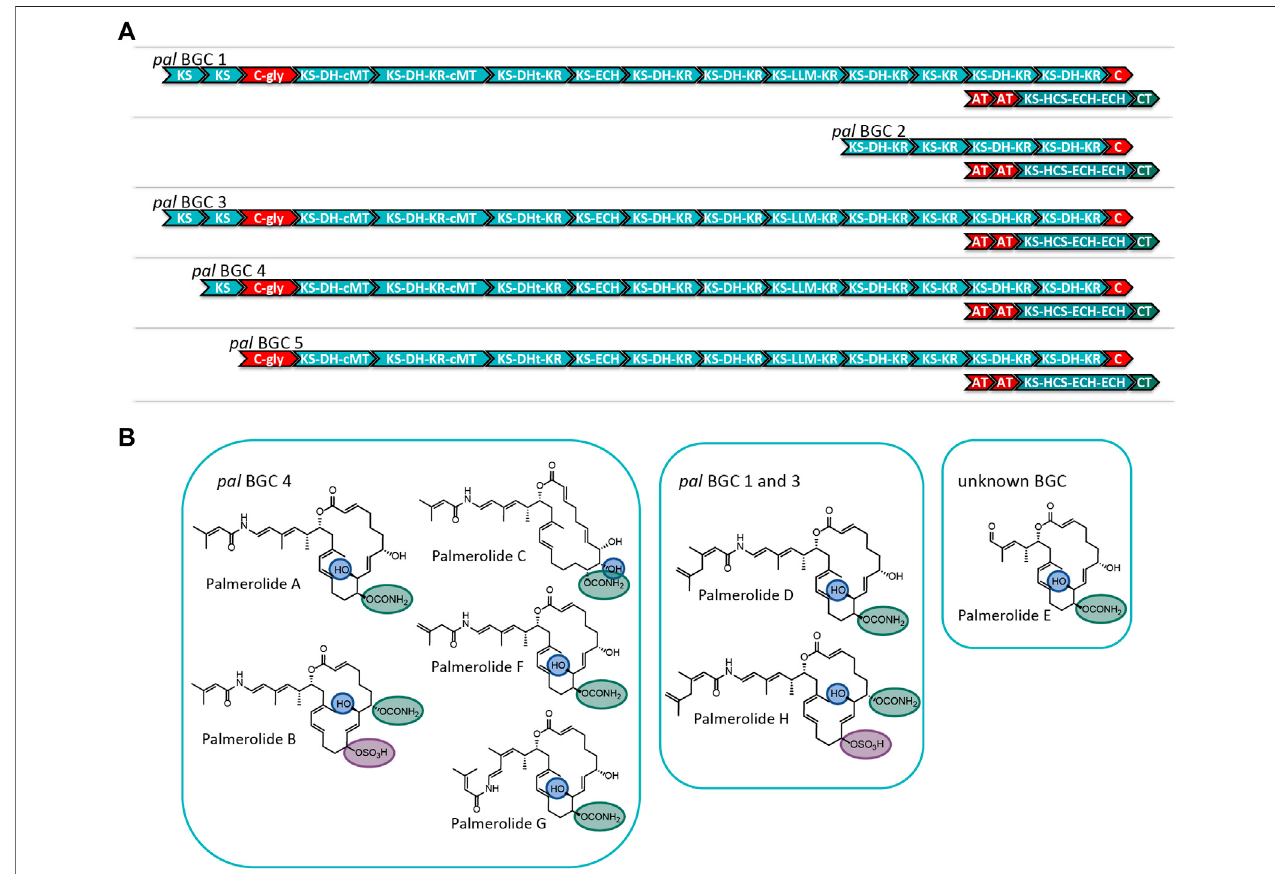
FIGURE4|(A) Comparisonofthemodularstructure ofthe5 pal BGCs. (B) Familyofpalmerolides.Much ofthestructural diversity canbeexplainedbydifferences due to starter unit promiscuity, sites of action for the trans -acting tailoring enzymes, and differences in the core modules of the multiple pal BGCs. It is proposed that pal BGC 4 is responsible for not only palmerolide A, but also palmerolide B, palmerolide C, palmerolide F, and palmerolide G. It is interesting to note that the modular structureofthedomains responsibleforbiosynthesisareequivalent for pal BGC1and pal BGC3.ThesetwoBGCscontainanadditional KSdomain ascompared to pal BGC 4 and are likely responsible for the biosynthesis of palmerolide D and palmerolide H.